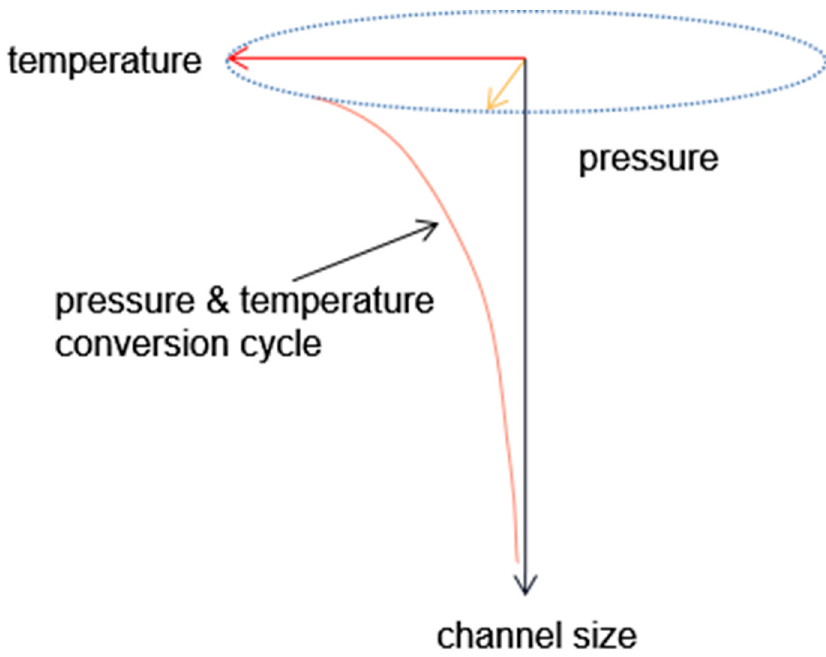
Figure 2. Schematic diagram of pressure and temperature conversion cycle.